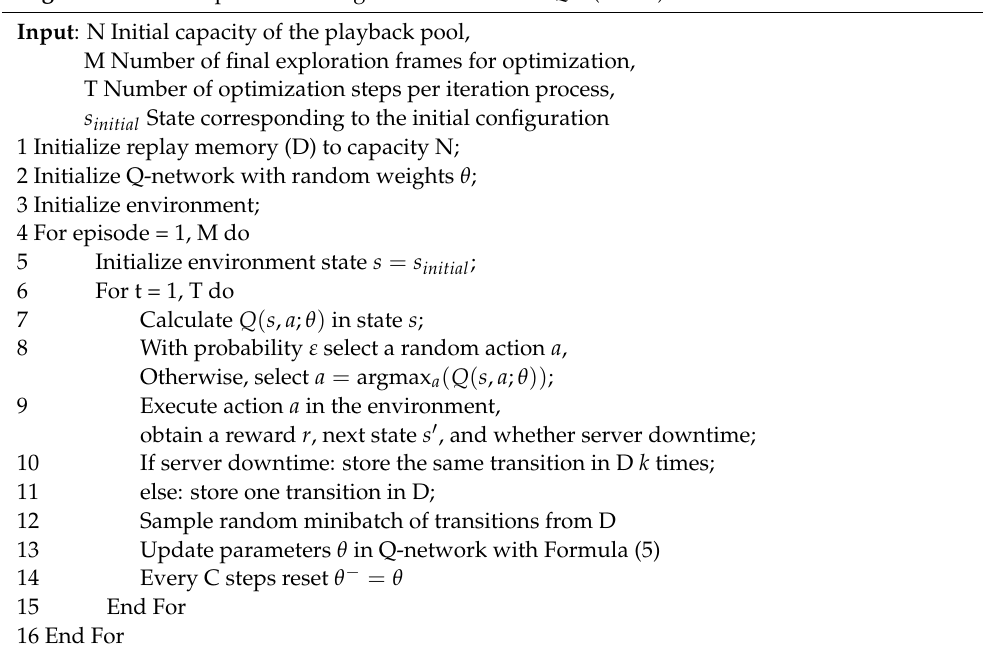
Algorithm 1 BIOS optimization algorithm based on DQN (Part